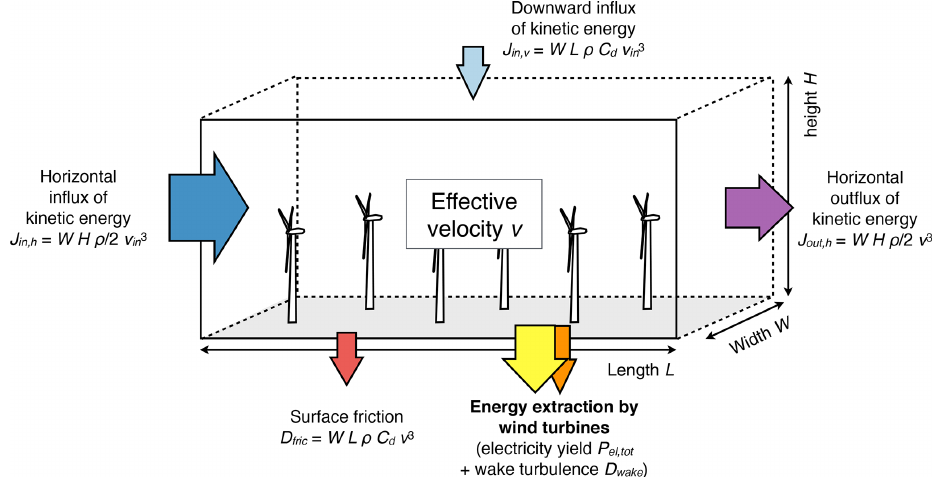
Figure 1. Illustration of the Kinetic Energy Budget of the Atmosphere (KEBA) approach to estimate regional wind energy potentials, which considers the fluxes of kinetic energy in and out of a virtual volume that encloses a given region of dimensions L · W · H to infer limits to electricity generation as well as wind speed reductions. The mathematical formulations of the fluxes are provided next to the